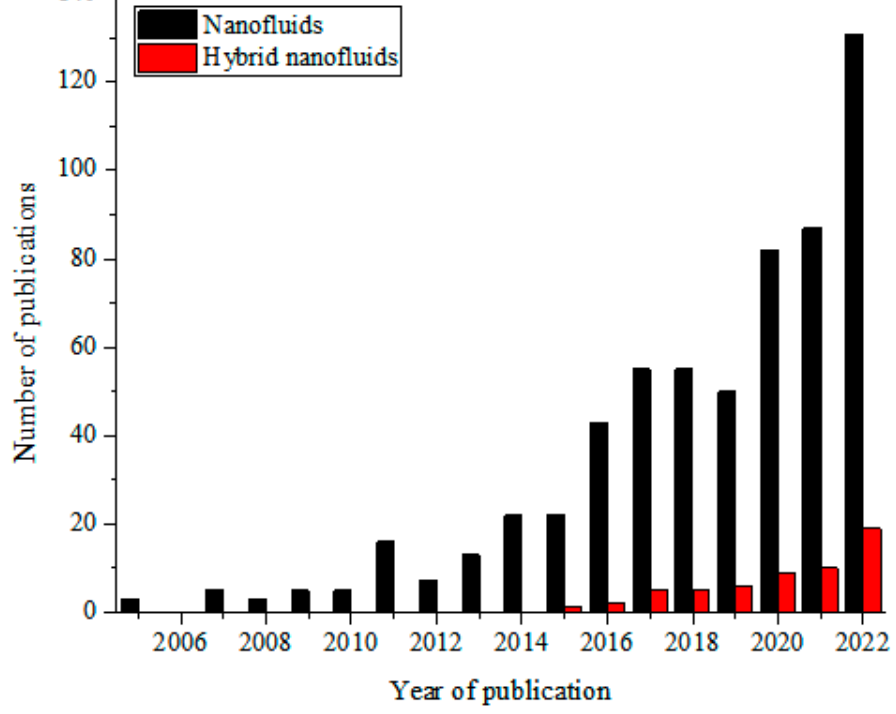
Figure 2. Temporal publication trend of review papers on nanofluid and hybrid nanofluid studies (Source: SCOPUS (26 December 2022)).